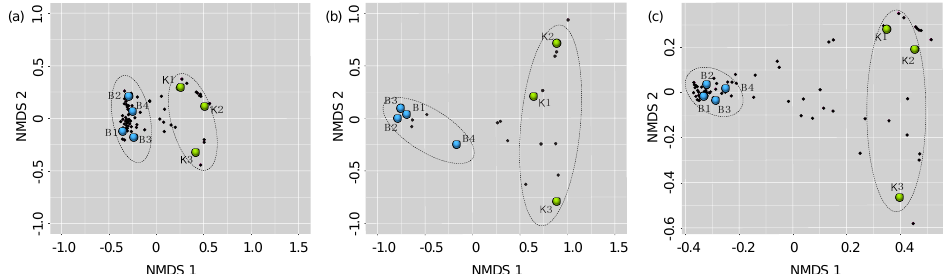
Figure 1. Nonmetric multidimensional scaling of ( a ) bacterial, ( b ) fungal, and ( c ) overall microbial community compositions of pollen provisions from Source K (green circles), and Source B (blue circles). Points that are close together are more similar in diversity and abundance to one another than points that are far apart. Each black circle represents a unique microbial taxon.